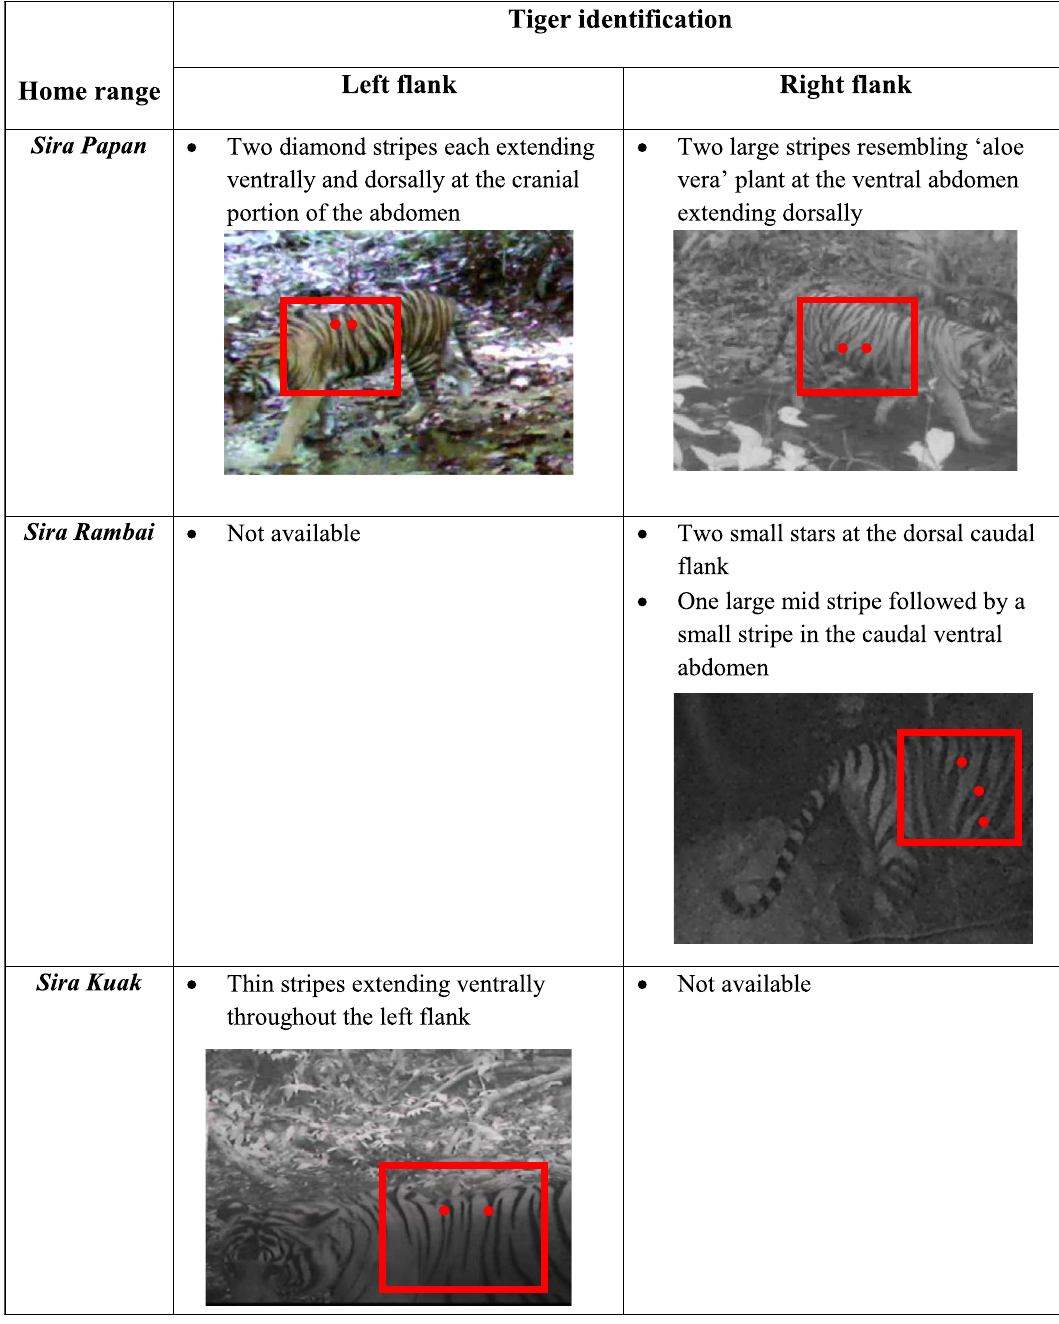
Table 3. Image identification of Malayan tiger spotted at the Royal Belum